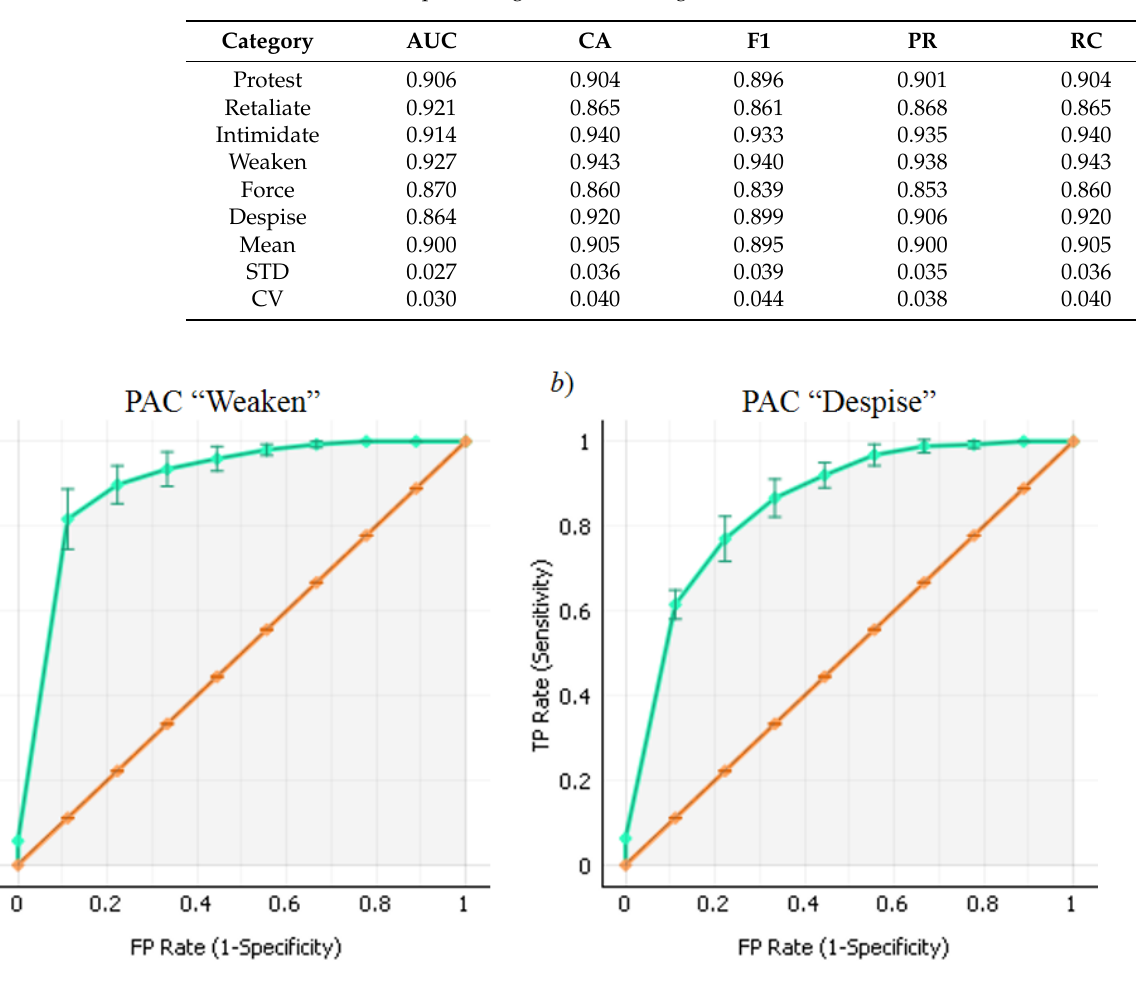
Table 5. XGB scores for predicting each class using OvR classification. Category